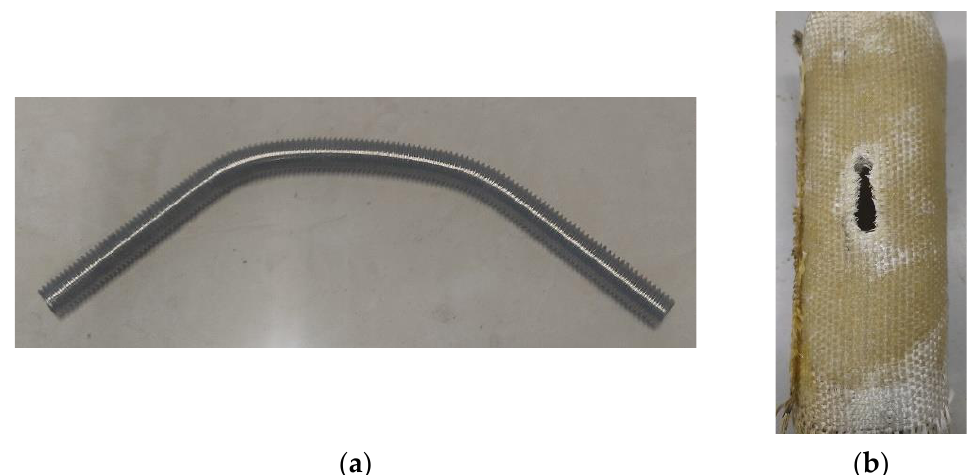
Figure 9. The failure mode of the components in the composite joint. ( a ) Failure mode of bolt; ( b ) Failure mode of bamboo wrapped with GFRP.